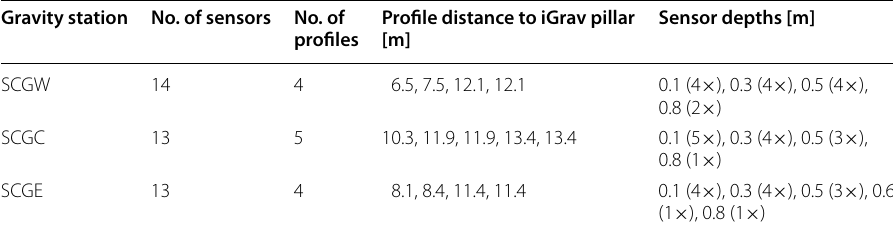
Table 1 Distribution of soil moisture sensors installed at different depths around each gravity station; some soil profiles are deployed at equal distances to the iGrav pillar (e.g. two profiles with 12.1 m distance at SCGW), in these cases the sensors are installed below different micro-topographic features (e.g. small hills or terrain